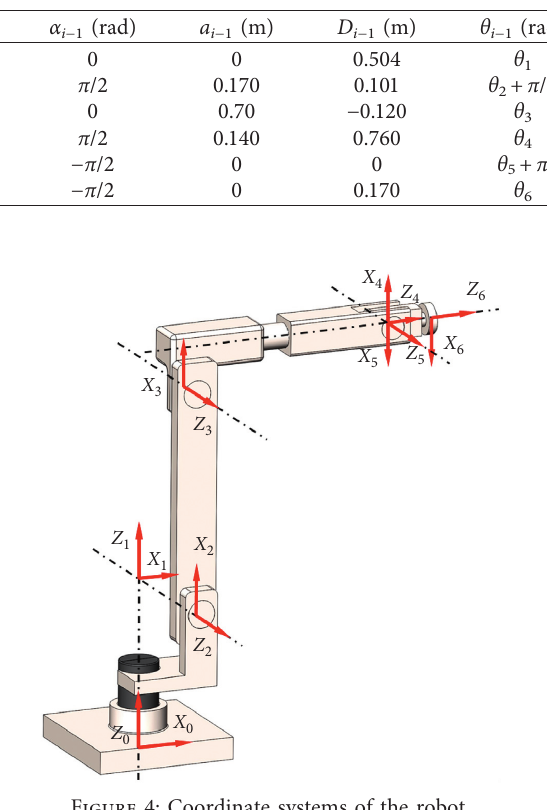
Figure 3: The flowchart of verification for the proposed model. Table 1: Kinematics parameters of the robot.